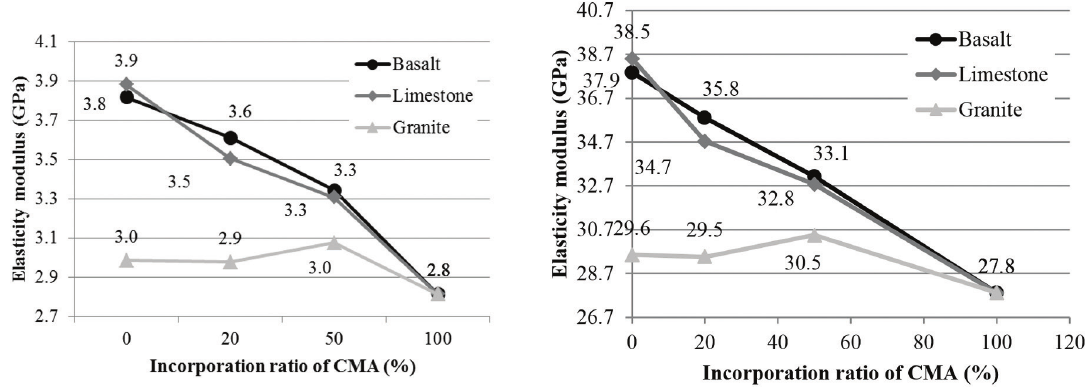
Figure 10. Elasticity modulus at 28 days.